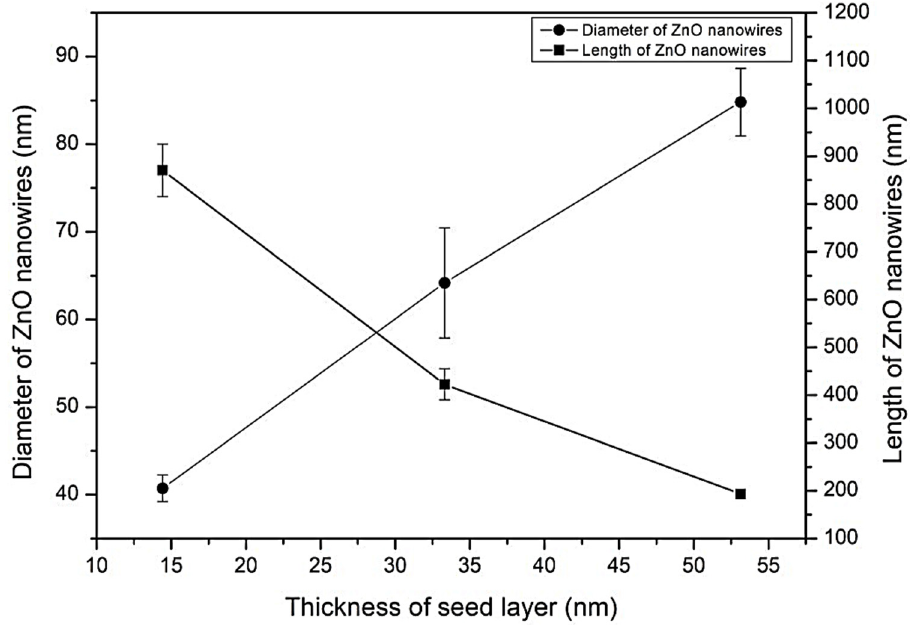
Figure 3. The length and diameter of ZnO nanowires grown. Table 3. Summary of the length and diameter of ZnO nanowires.